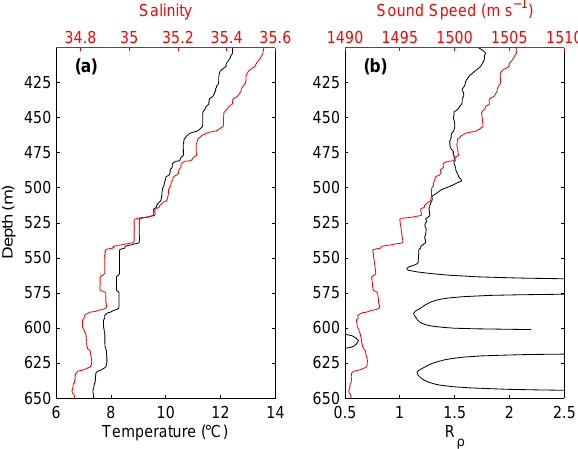
Fig. 6. Profiles of (a) temperature and salinity and (b) density ratio, R ρ and sound speed in the staircase (HRP dive 123). Sound speed and in-situ density profiles from this dive are used for the synthetic